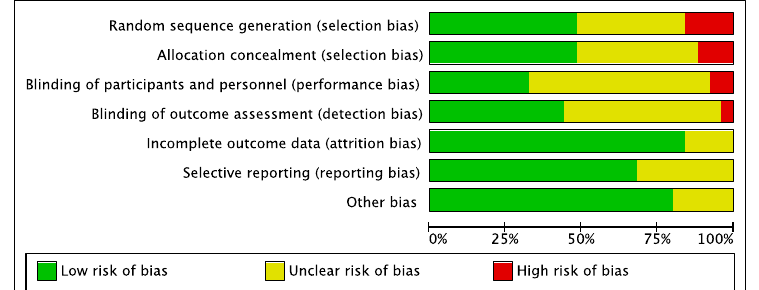
Figure 2. Risk of bias graph for included studies.